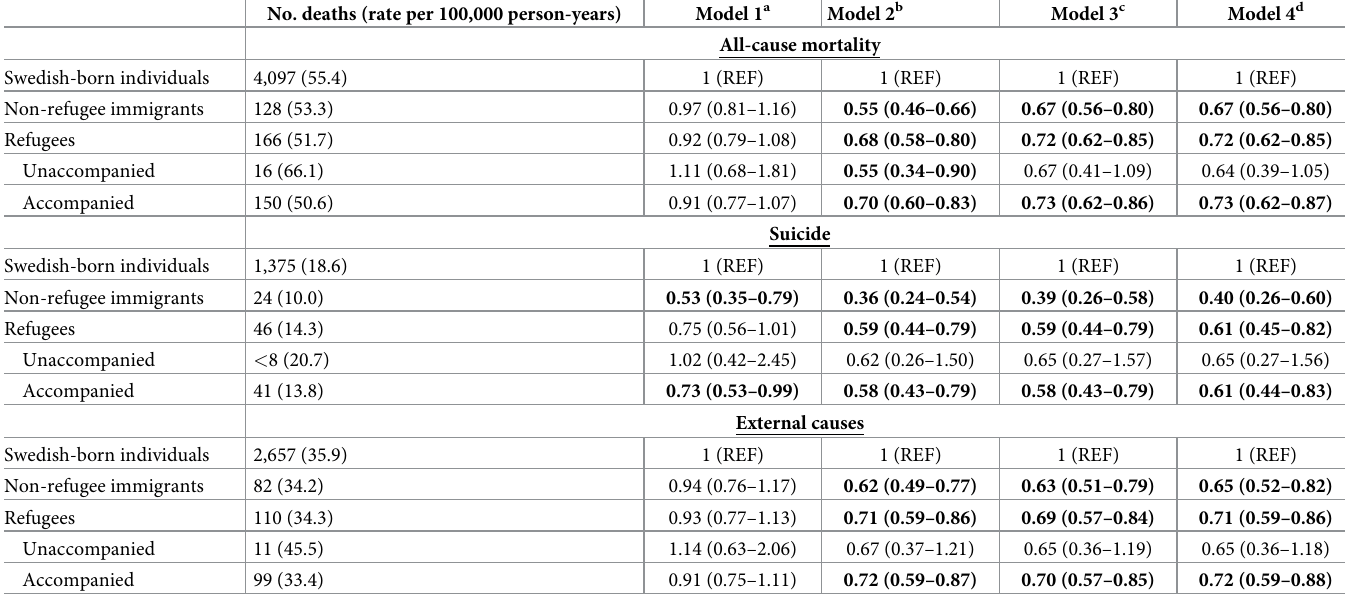
their partner or were single with children living at home. Migrants were more often unem- ployed and living in big cities compared to their counterparts in the host country. Table 2 displays the HRs and 95% CIs of all-cause and selected cause-specific mortality in refugees and non-refugee immigrants compared to Swedish-born individuals. After adjusting for covariates, non-refugee immigrants had the lowest statistically significant risk for all-cause mortality (aHR 0.67, 95% CI 0.56–0.80), mortality due to suicide (aHR 0.40, 95% CI 0.26– born individuals. Further, accompanied refugees also showed to be protected from all-cause mortality (aHR 0.73, 95% CI 0.62–0.87), mortality due to suicide (aHR 0.61, 95% CI 0.44– Swedish-born. Even though not statistically significant, a protective trend can be observed for Table 2. Risk of all-cause and cause-specific mortality in Swedish-born individuals and refugee and non-refugee immigrants, aged 19–25 years old residing in Swe- den in 2004. Hazard ratios (HRs) with 95% confidence intervals (CIs). No. deaths (rate per 100,000